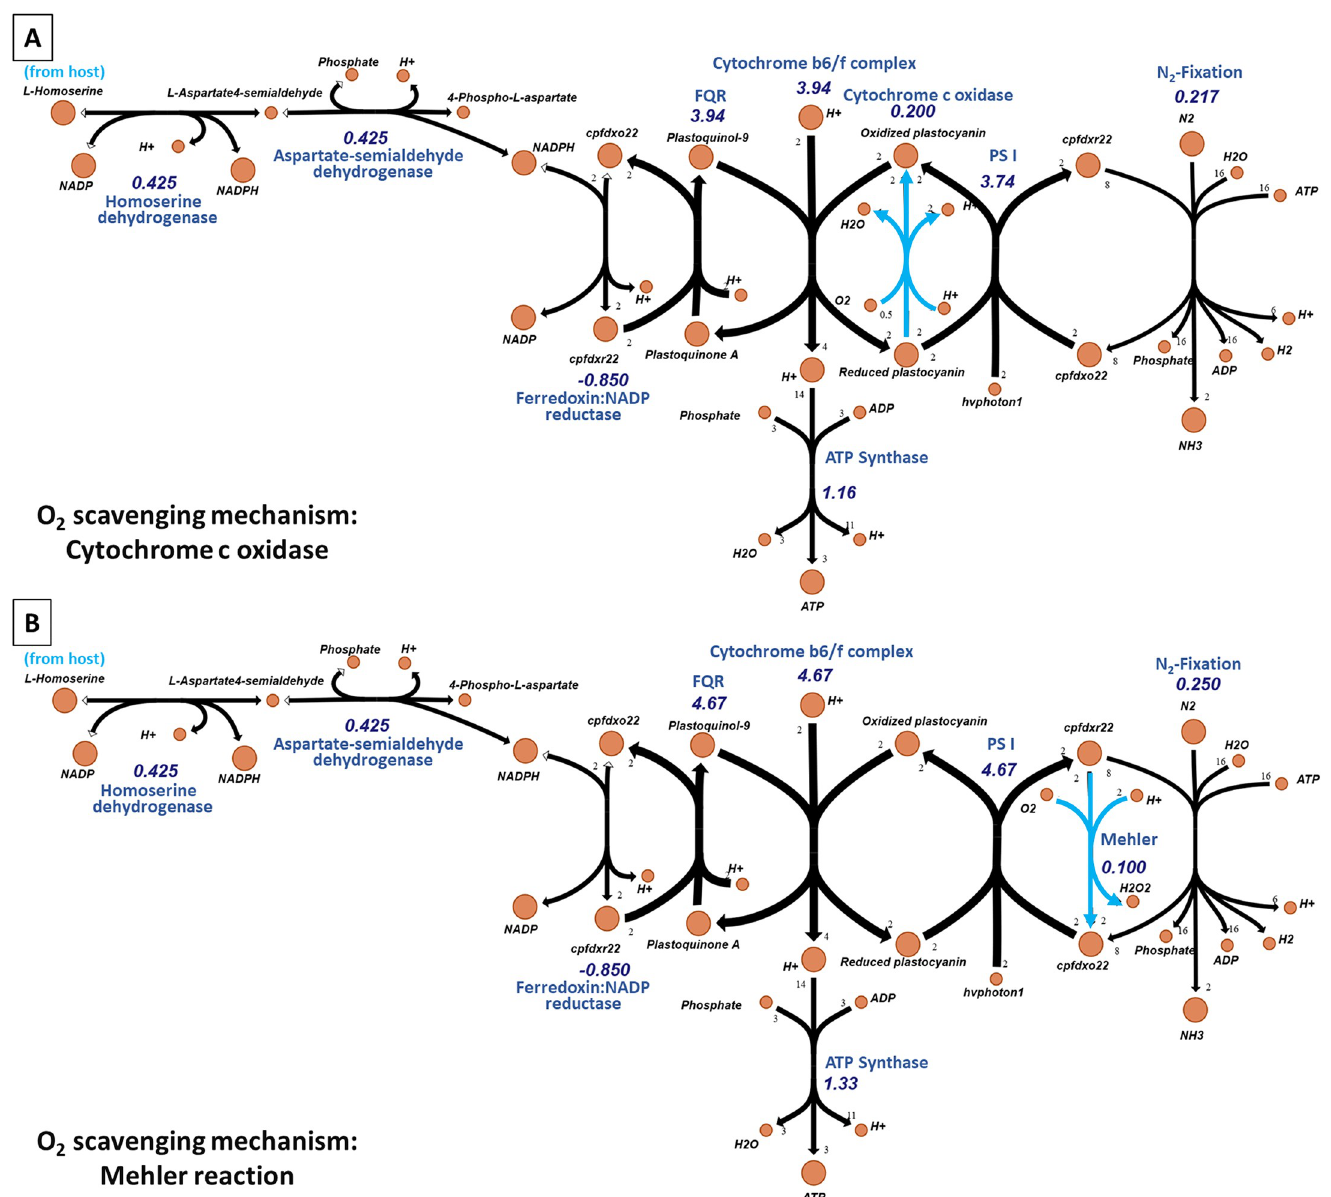
Fig 4. Calculated flux distributions under nitrogen fixation comparing two oxygen-scavenging mechanisms. Model-predicted reaction fluxes (values in mmol gDW -1 hr -1 ) when maximizing nitrogen fixation flux and employing (A) cytochrome-dependent respiration, and (B) the Mehler reaction to consume oxygen at 0.1 mmol -1 gDW hr -1 . The competing mechanisms are shown in cyan. Metabolites are shown as nodes (in orange) and reactions as directed edges connecting them. The thickness of an edge corresponds to the flux through it. Reaction fluxes were computed using a basis of 10 mmol gDW -1 hr -1 of supplied CO 2 .